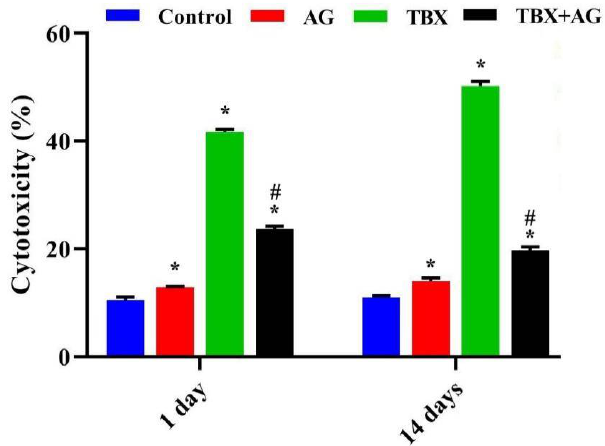
Figure 6. The protective effect of AG against TBX-induced alterations in the viability of peripheral blood leucocytes of treated rats after 1 and 14 days of the experiment. *: Significant ( p < 0.001) rela- tive to untreated groups. #: Significant ( p < 0.001) relative to TBX-treated groups. Data were